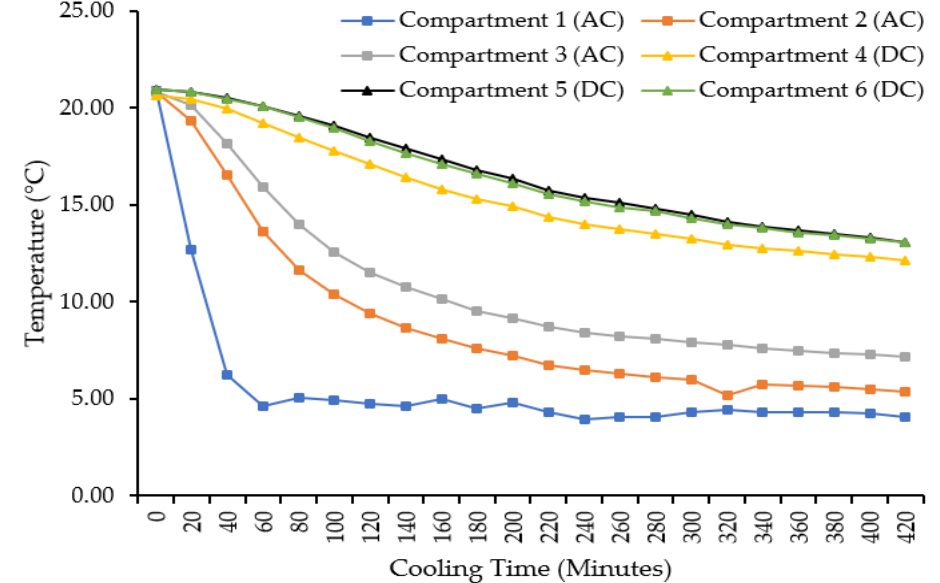
Figure 3. Temperature changes in individual compartments (without air circulation).